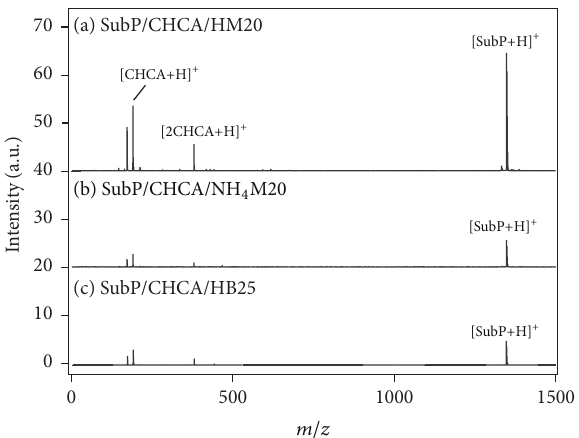
Figure 2: Mass spectra of SubP measured with (a) CHCA/HM20, (b) CHCA/NH 4 M20, and (c) CHCA/HB25.